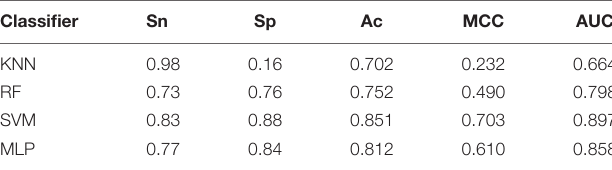
TABLE 2 | The comparison of different classifiers for predicting phage